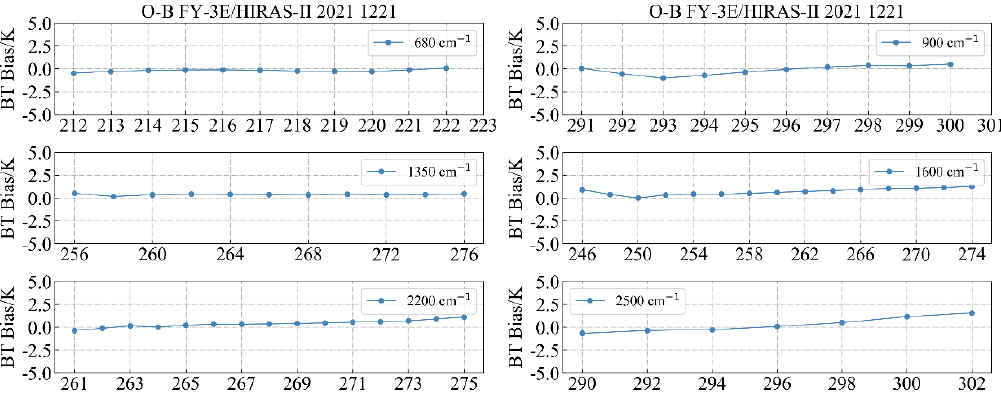
Figure 21. The bias of OMB distribution with target temperature.